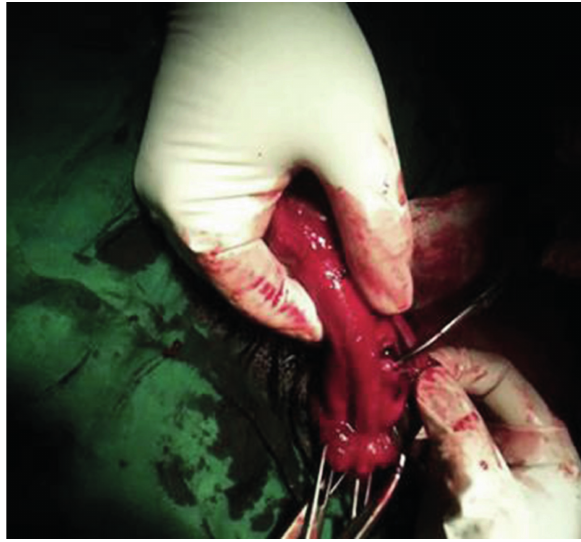
Figure 3 - The rent in tunica albuginia and corpora cavernosum. The haematoma within the tunica albuginea was evacuated and the corporal tear was